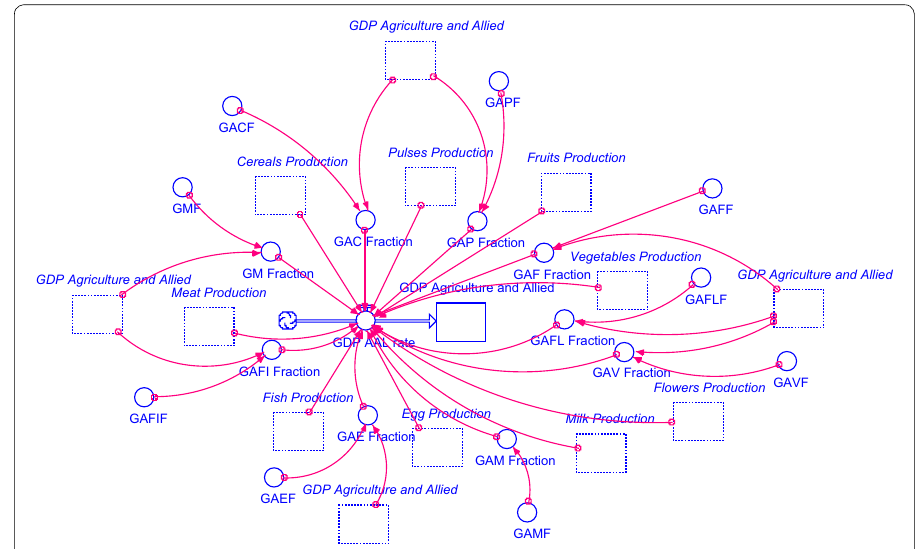
Fig. 6 Diagram showing system dynamics model for GDP from agriculture and allied